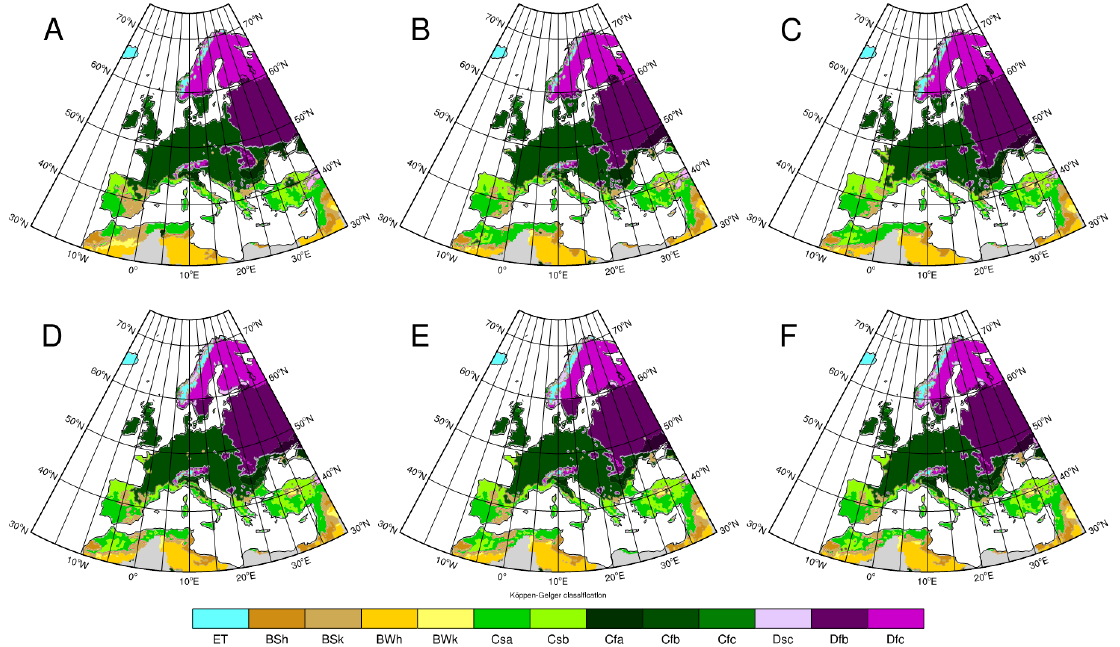
Figure 9. Simulated K-G climate classification according to E-OBS ( A ) and power transformation of precipitation and variance scaling of temperature correction in ALADIN ( B ), HIRHAM ( C ), RegCM ( D ), RAMCMO2 ( E ) and RCA ( F ) in the test period in 1981 − 2000.